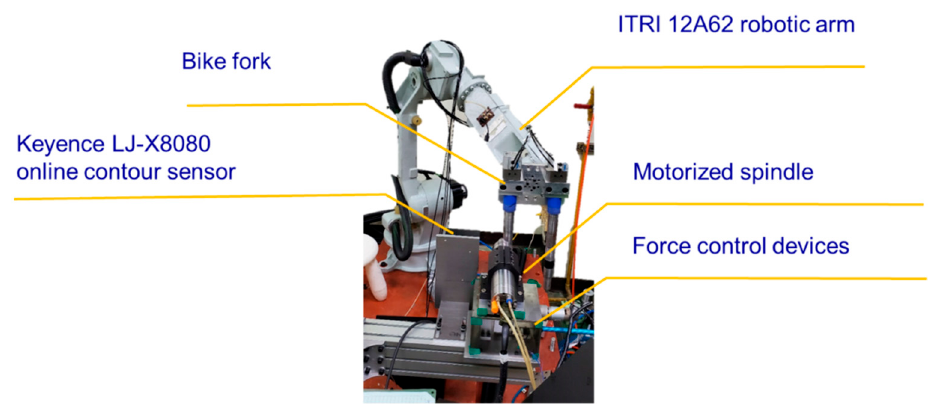
Figure 9. Verifying the automatic deburring system.